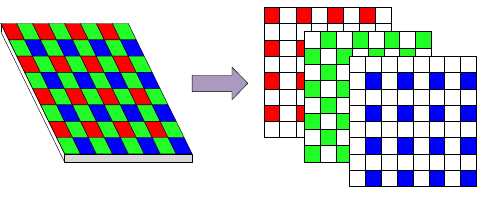
Figure 2. Color filter array (CFA).